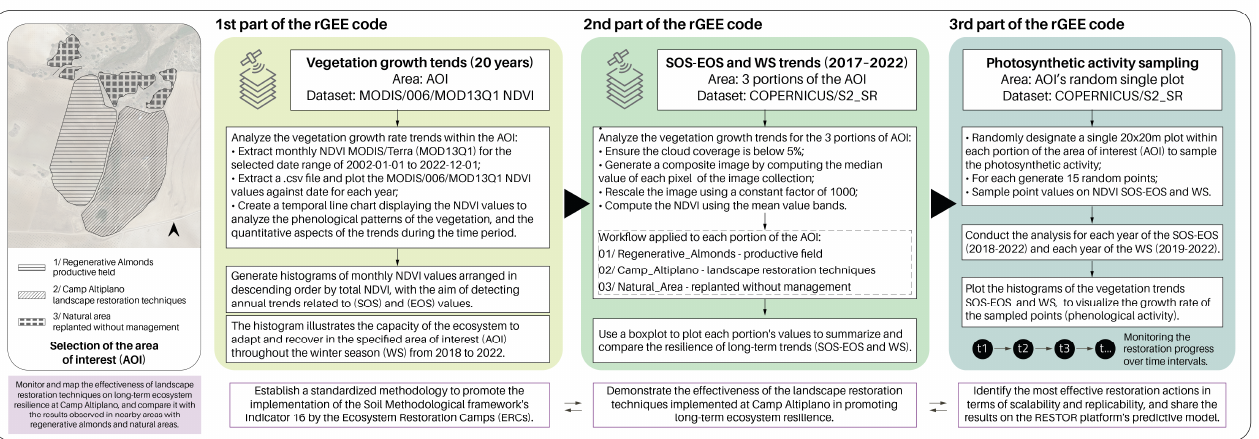
Figure 5. The methodological framework depicts the three primary components of the rGEE code workflow, along with the general research question and macro ‐